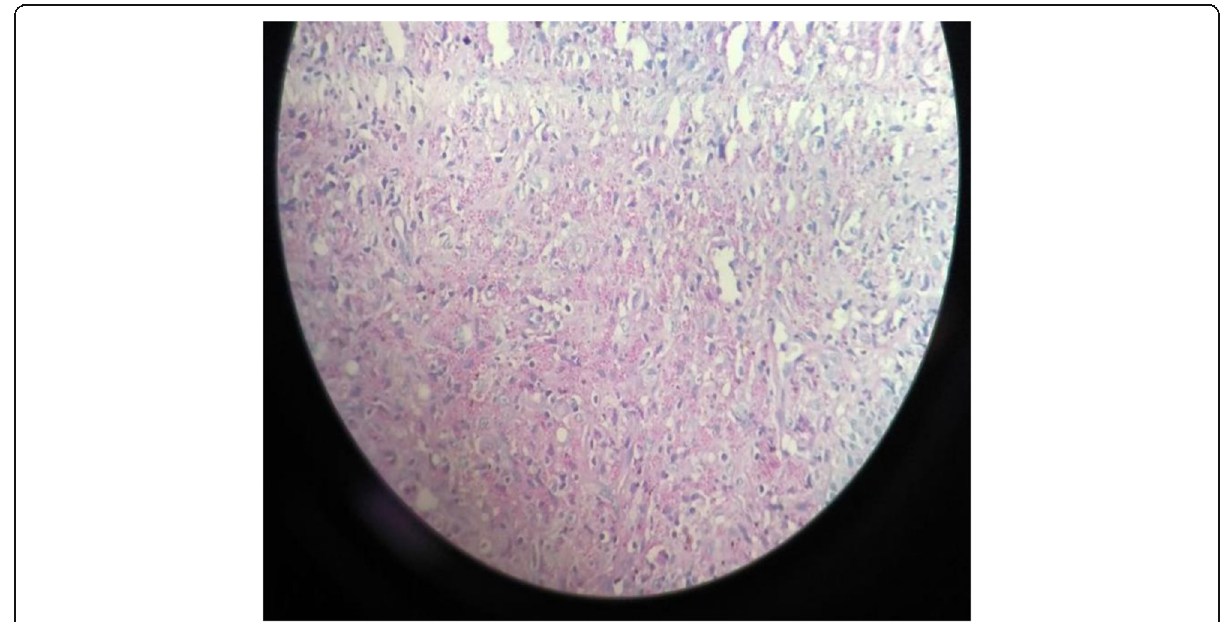
Fig. 3 HPE (×4 magnification) showing lining of stratified squamous epithelium with diffuse sheets of macrophages with interspersed mature